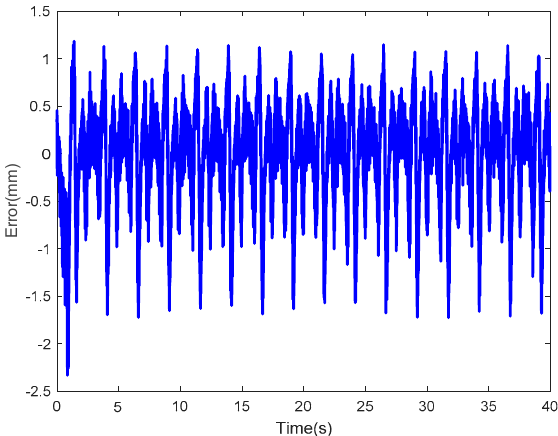
Figure 22. Results of the LSSVM ‐ NARX model at sinusoidal actuating voltage with amplitude of 3V and frequency of 5/2 π Hz.